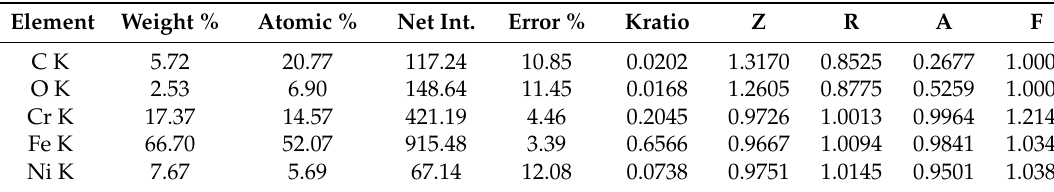
Table 4. Composition of precipitates.